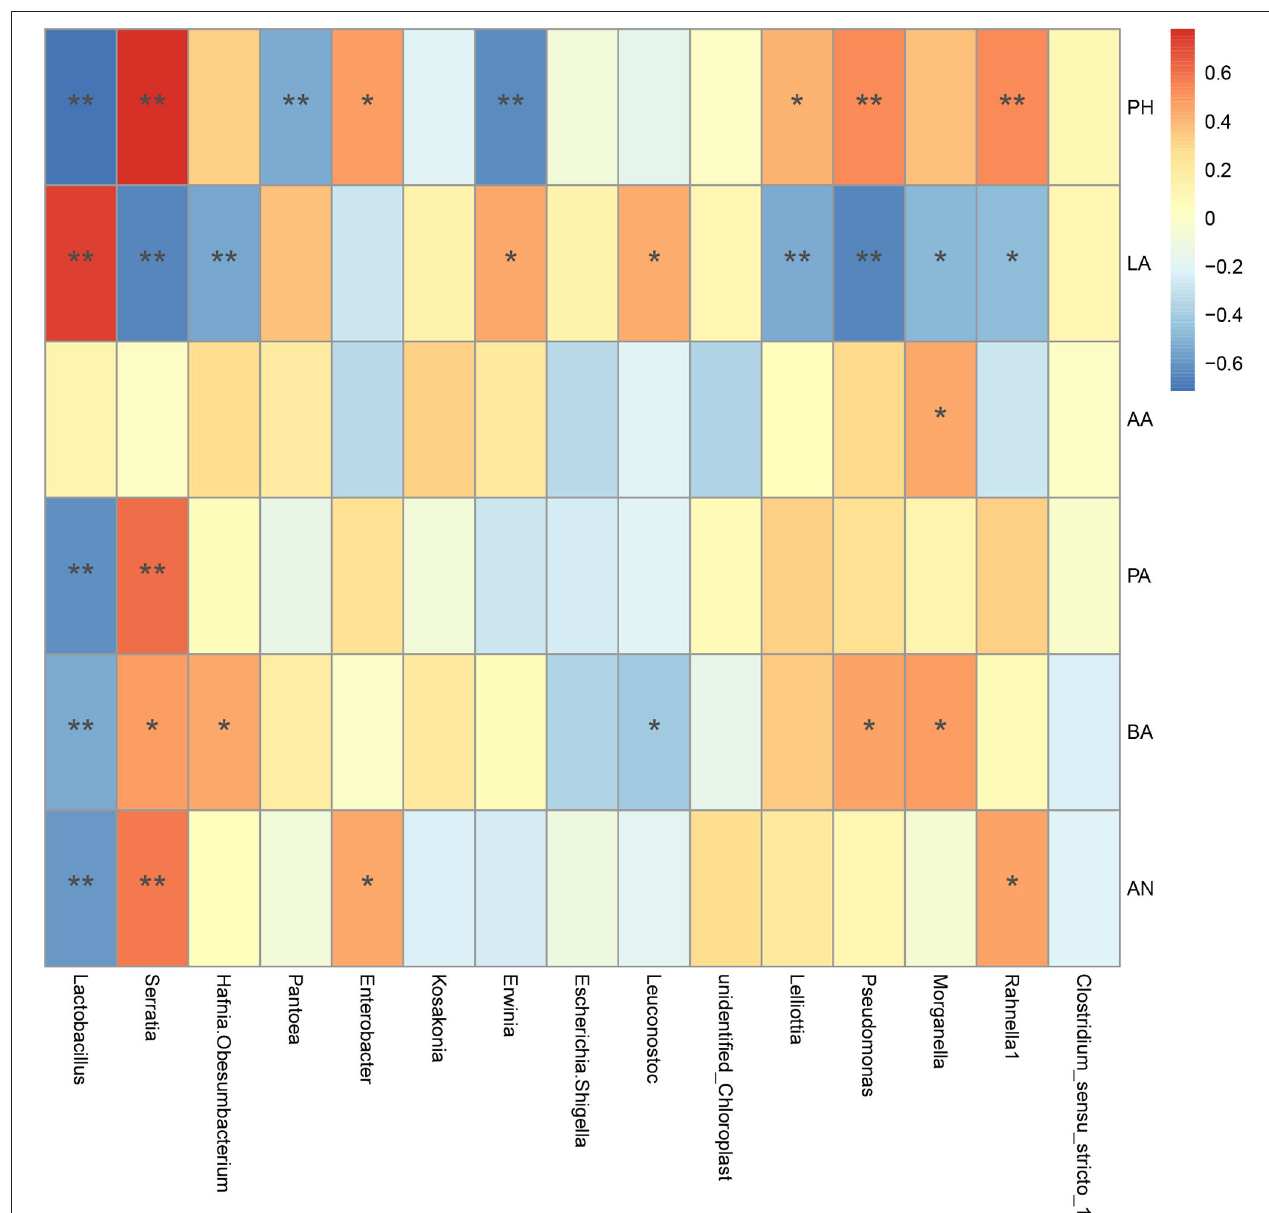
FIGURE 6 | Spearman correlation heatmap of bacterial community with fermentation characteristics at the genus level. A positive correlation was indicated by red color, and negative correlation was indicated by blue color. “*” and “**” represent P < 0.05 and P < 0.01, respectively. LA, lactic acid; AA, acetic acid; PA, propionic acid; BA, butyric acid; AN, Ammonia